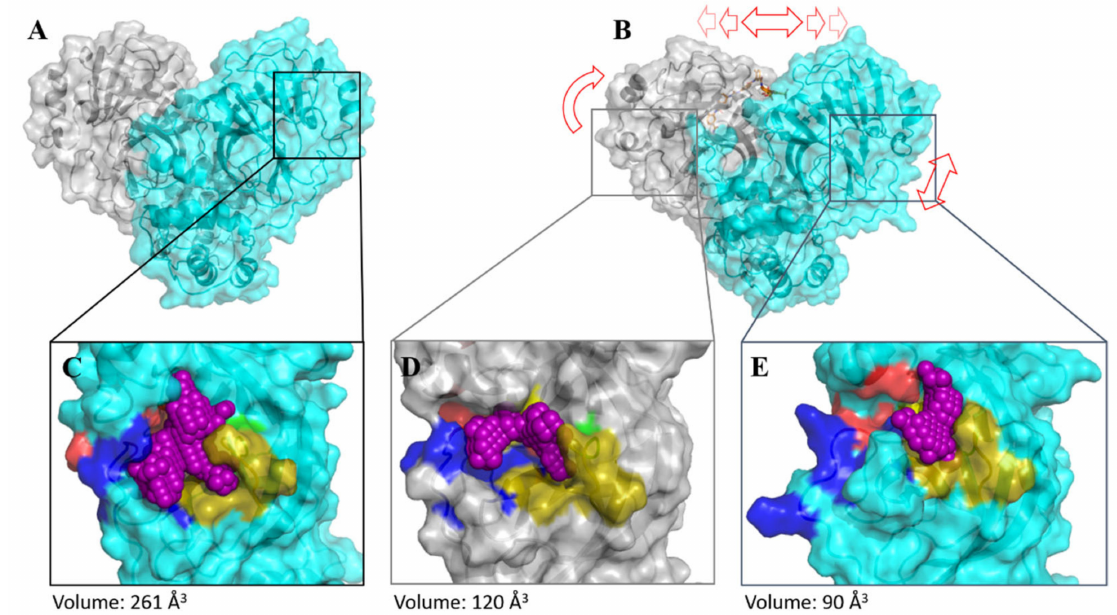
Figure 7. Comparison of SARS-CoV-2 3CL pro with and without suramin after MD simulation. Protomer 1 is colored in turquoise, protomer 2 is colored in grey, and the active site pocket volume is colored in violet. Red arrows highlight a conformational change in the SARS-CoV-2 3CL pro –suramin complex. ( A ) SARS-CoV-2 3CL pro dimer. ( B ) SARS-CoV-2 3CL pro –suramin complex. ( C ) Active site pocket volume of SARS-CoV-2 3CL pro . Substrate-binding subsites are highlighted in green for S1, gold for S1, red for S2, and blue for S3. ( D ) Active site pocket volume of protomer 2. ( E ) Active site pocket volume of protomer